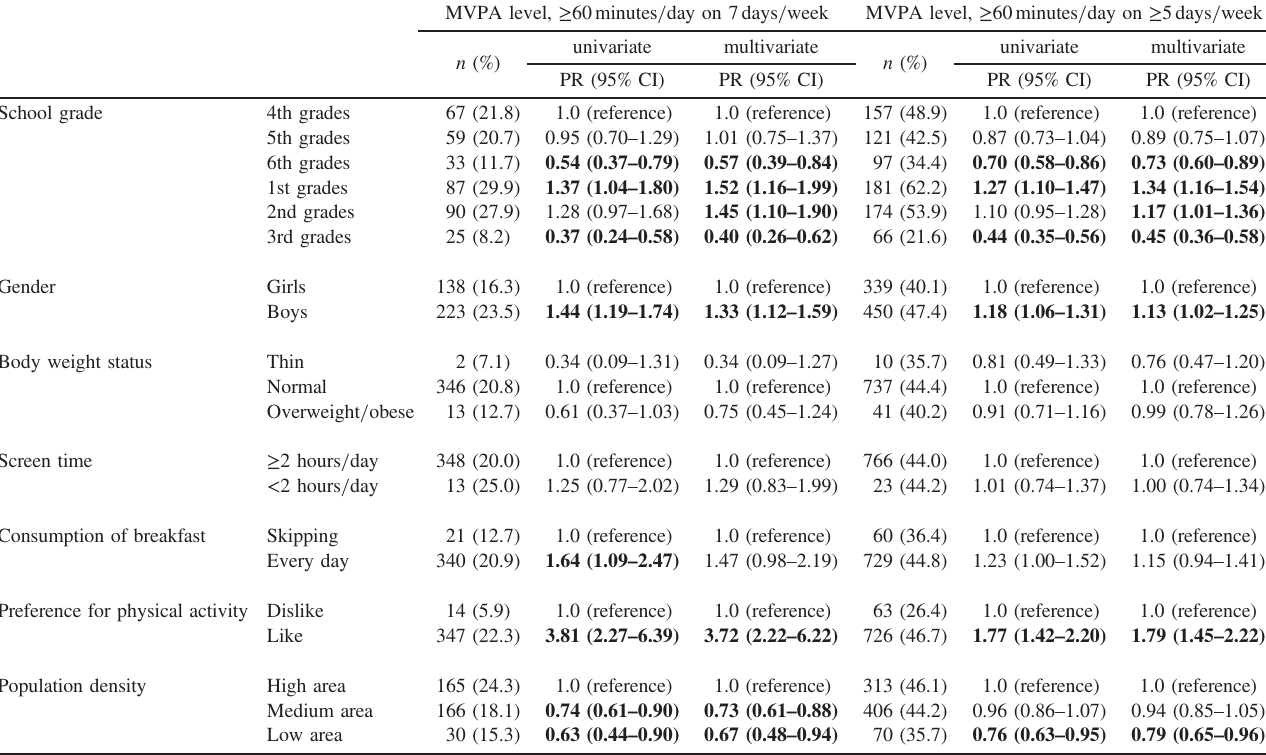
Table 2. Correlates for moderate-to-vigorous physical activity among Japanese children and adolescents ( n =